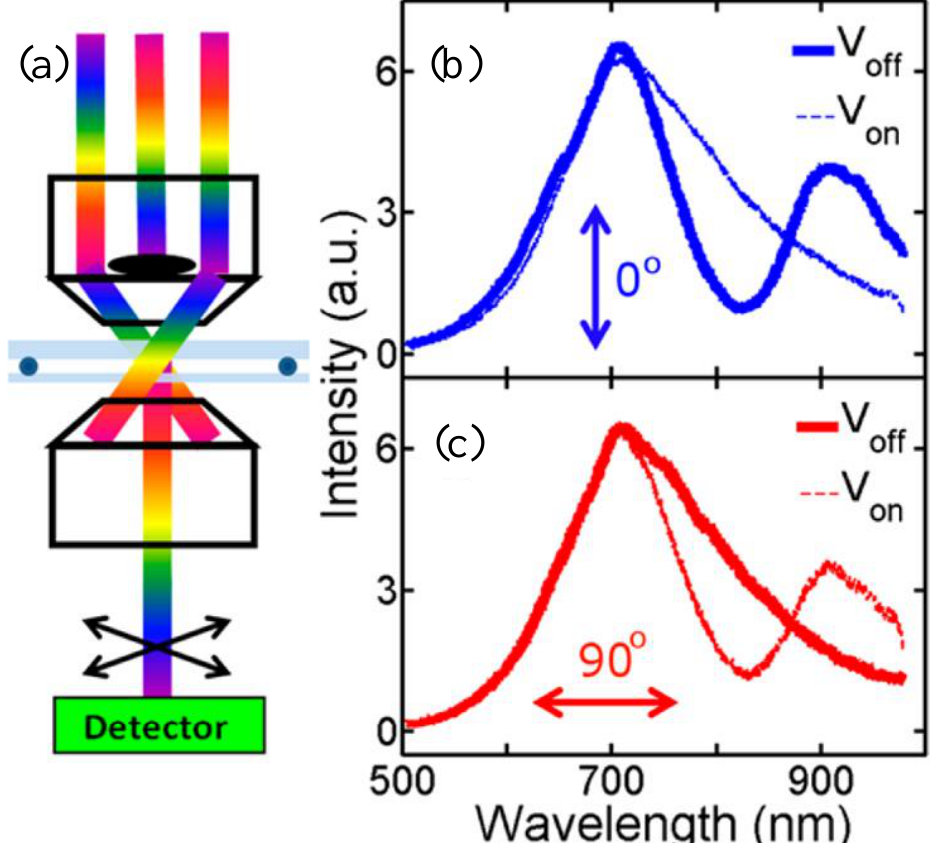
Figure 12. Dynamic manipulation of the Fano resonance using LCs. ( a ) Schematic diagram of the experimental setup of dark field microspectroscopy. ( b , c ) Measured scattering spectra as a function of wavelength for an individual octamer nanostructure at different polarization of ( b ) 0° and ( c ) 90°. Reproduced with permission from [117]. Copyright American Chemical Society, 2012.